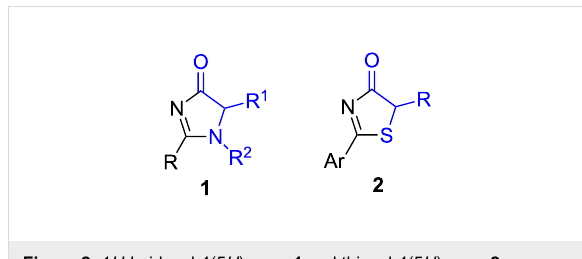
Figure 1: Some α -substituted heterocycles for asymmetric catalysis, their reactivity patterns against enolization, and resulting adducts after catalytic reaction and hydrolysis.